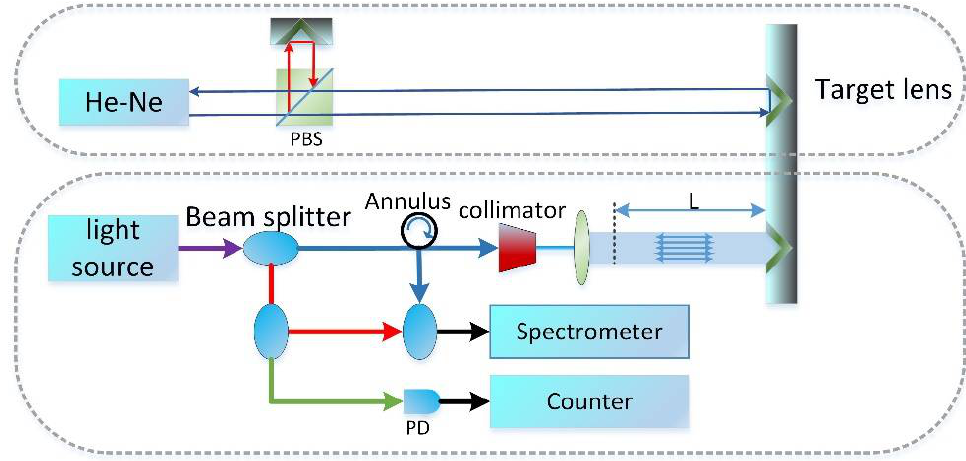
Figure 6. Layout of dispersive interferometry experiment.